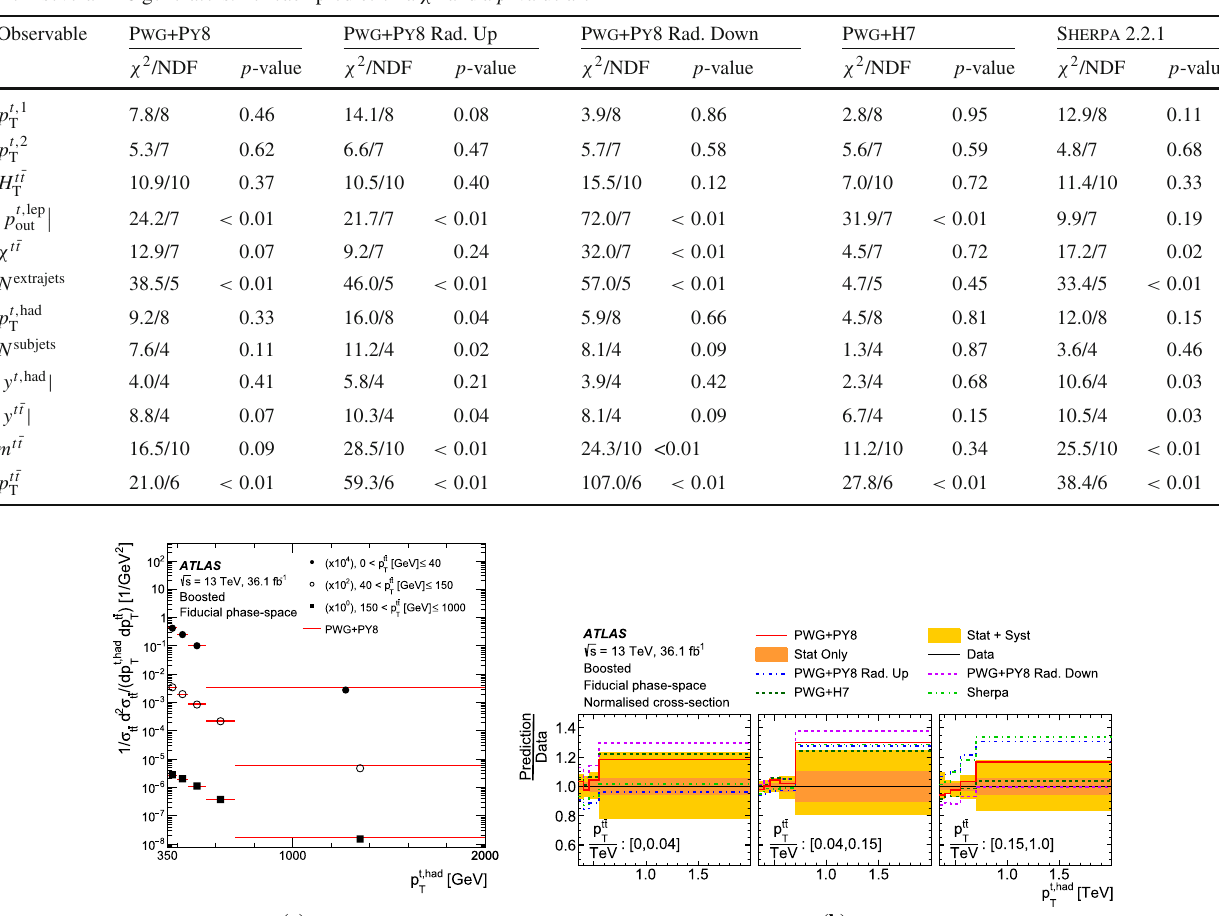
Table 14 Comparison of the measured particle-level absolute single- differential cross-sections in the boosted topology with the predictions from several MC generators. For each prediction a χ 2 and a p -value are